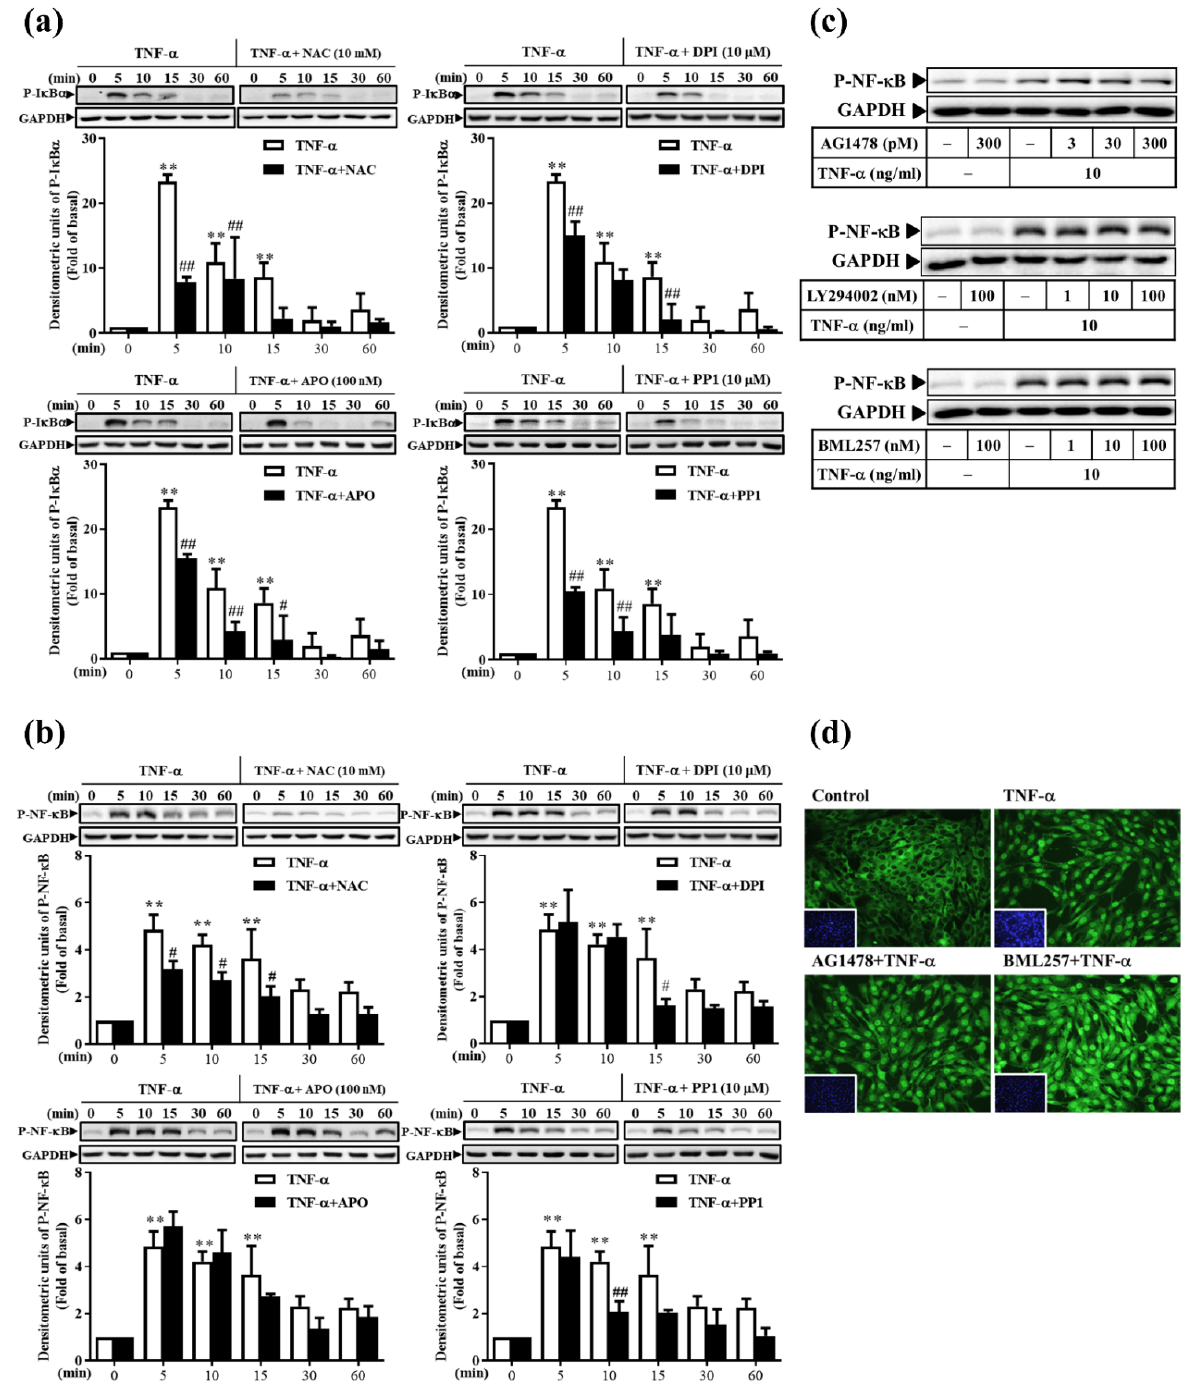
Figure 8. The TNF- α -induced NF- κ B activation via c-Src-driven ROS was independent from the EGFR signaling pathway. ( a,b ) Cells were pre-treated with NAC, DPI, APO, or PP1, followed by TNF- α treatment for various times. ( a ) I κ B α and ( b ) NF- κ B activation was analyzed by Western blotting. ( c , d ) Cells were pre-treated with AG1478, LY294002, or BML257, followed by TNF- α treatment for 5 min. NF- κ B activation was analyzed by ( c ) Western blotting and ( d ) immunofluorescence staining. The results are presented as the mean ± SD from 4–6 experiments and analyzed using one-way ANOVA followed by Dunnett’s post hoc test. ** p < 0.01, compared with the untreated group. # p < 0.05, ## p < 0.01, compared with the TNF- α treatment group.